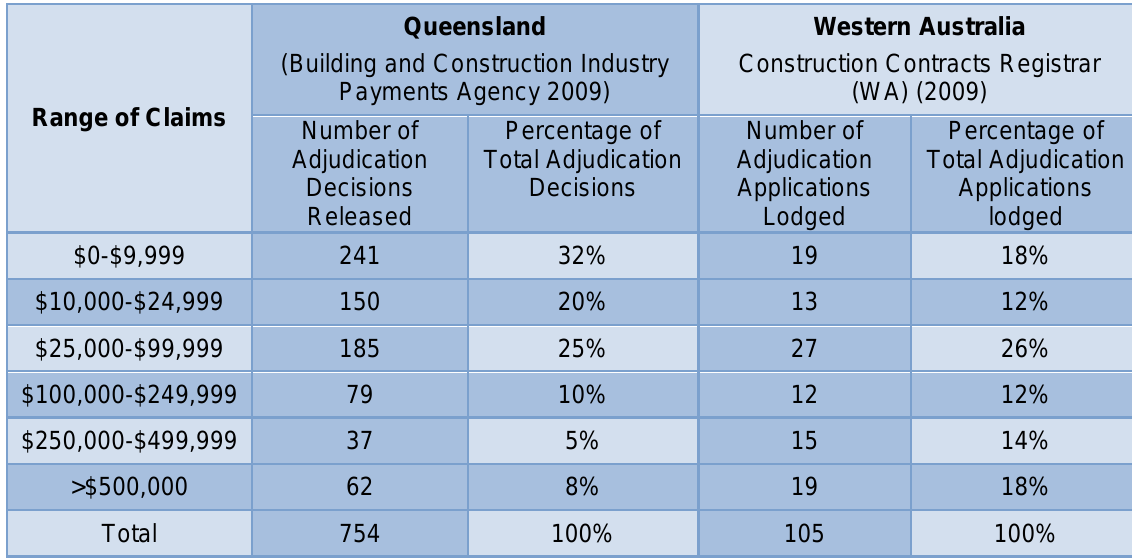
Table 3 Number of adjudications by claim value in Queensland and WA, 2008/2009